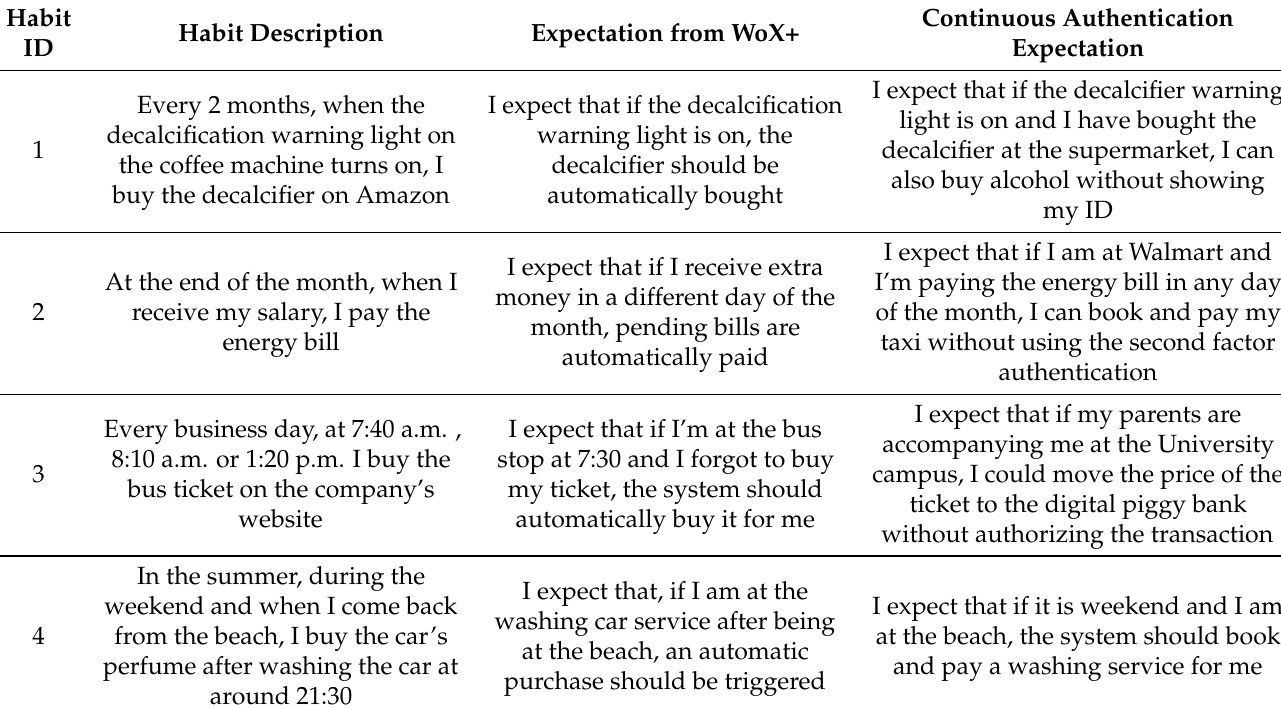
Table 1. Habits and expectations from the